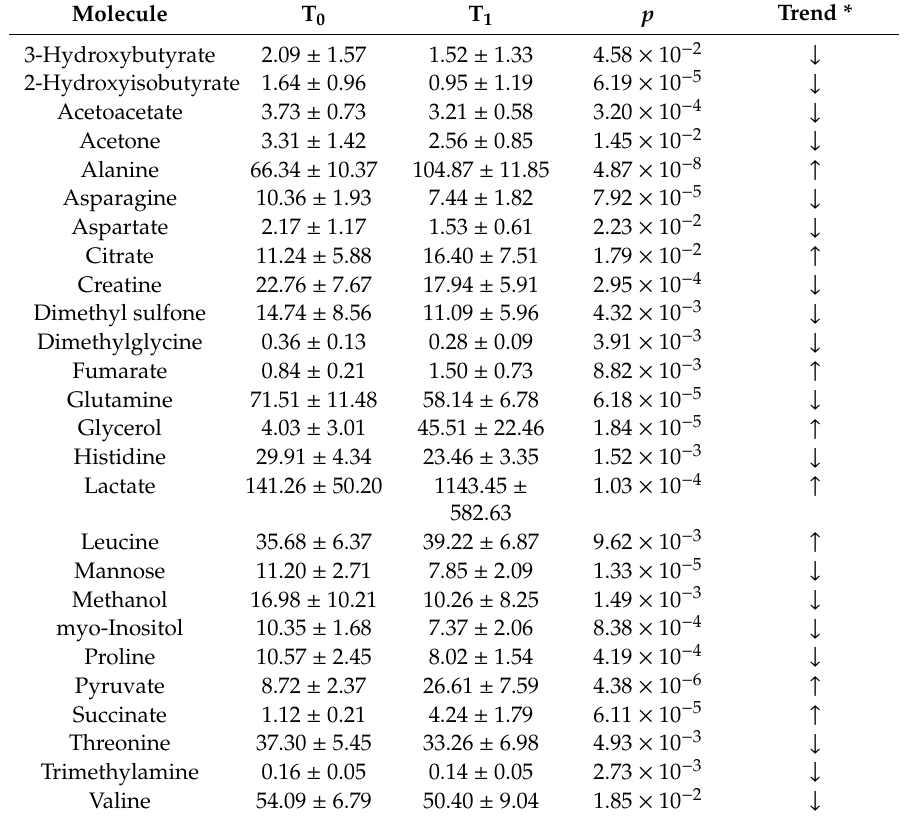
Table 1. Serum metabolites with significantly di ff erent concentration ( µ mol / L; mean ± SD) before (T 0 ) and after (T 1 ) exercise.